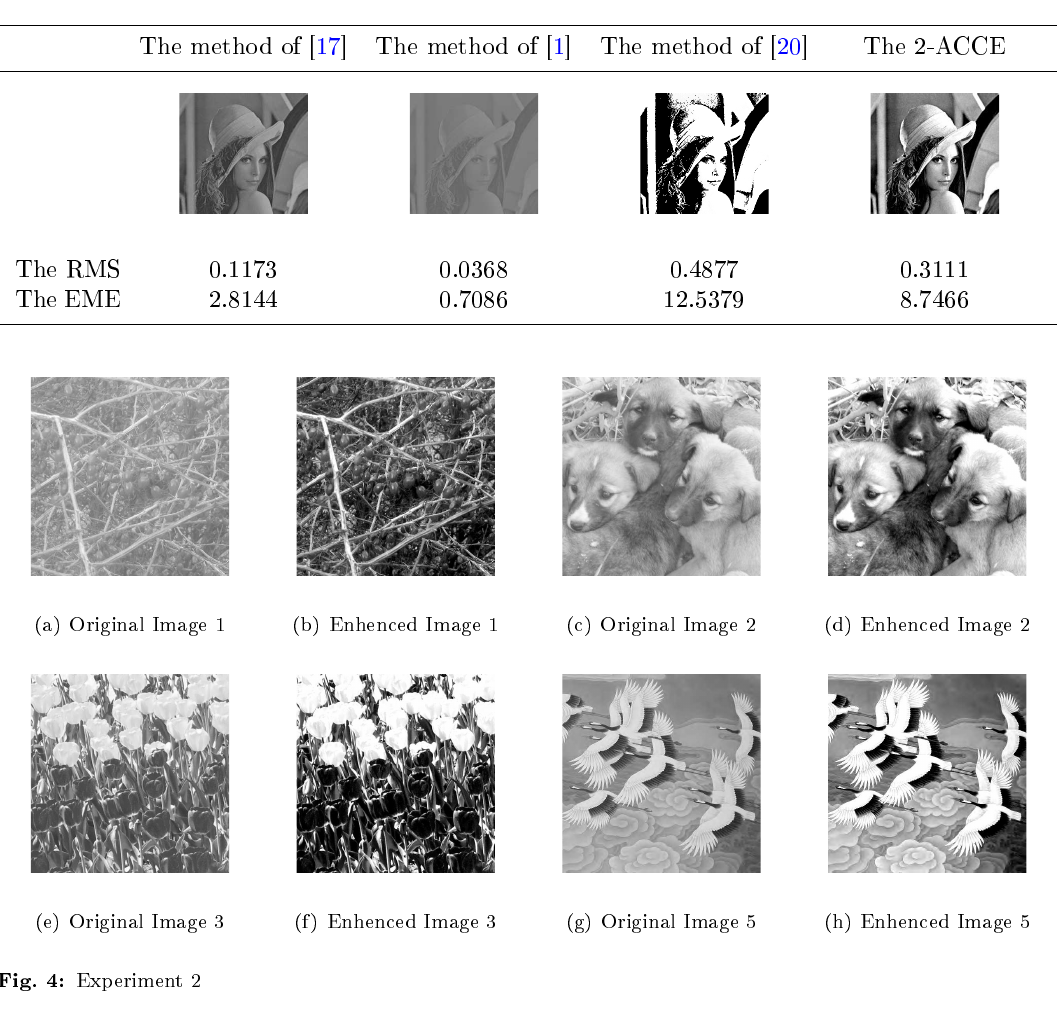
Tab. 2: The results of contrast enhancement method